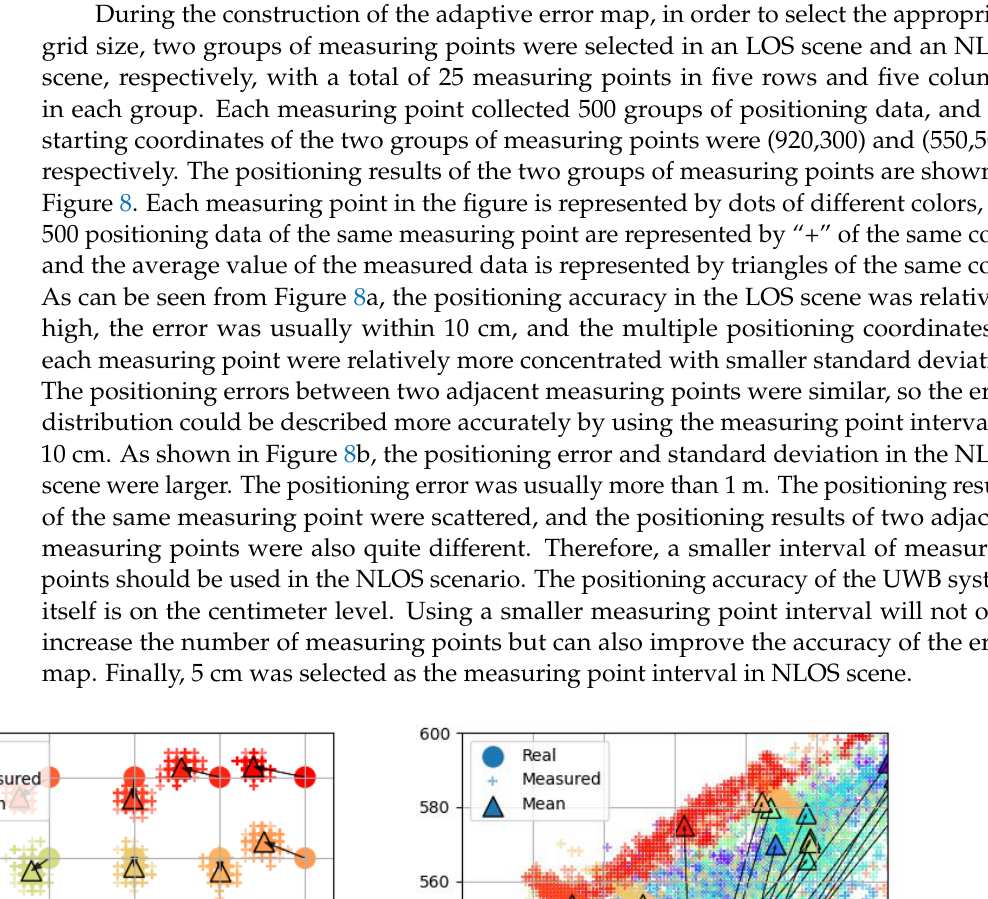
Figure 9. Adaptive measuring point density diagram. To mitigate the positioning error, the neural network model proposed in Section 3.4 needs to be trained. The model was pretrained by generated virtual data based on the error model, and then the model was corrected using the real measurement data. The vir- tual data were generated at 10 cm intervals; the experimental scene contained 185 × 85 points, each point generated 20 × 8 groups of data, and each group contained the real